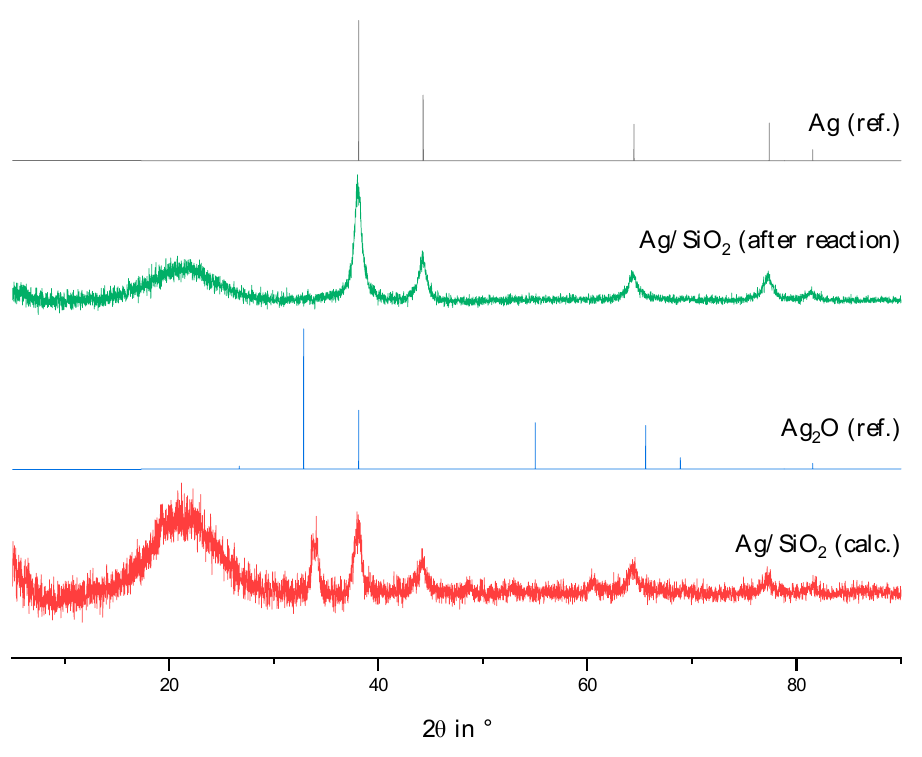
Figure A9. P-XRD of calcined copper catalyst before reaction (calc.) and after reaction.